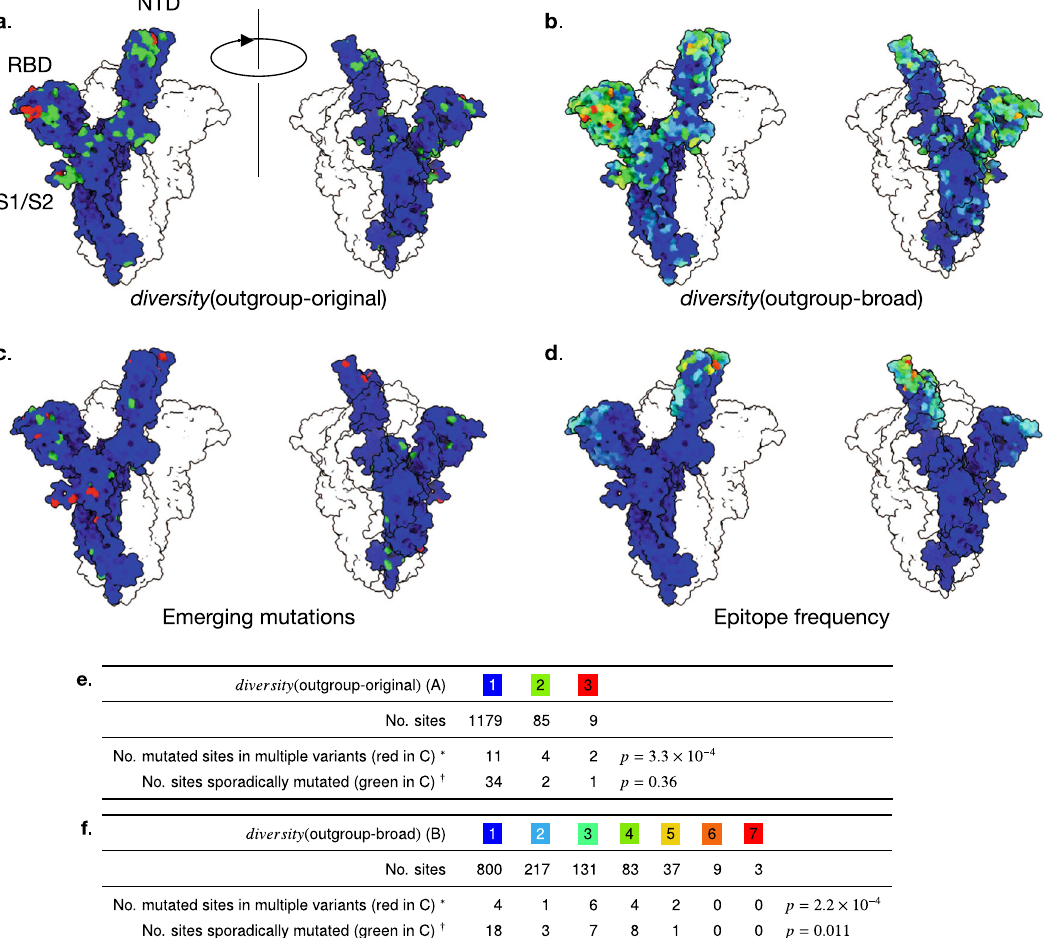
Fig. 1 Diversity and other indices mapped on structure of the S protein, visualized by ChimeraX 28 . A movie of the structure rotating is available at https:// mafft.cbrc.jp/alignment/pub/sarscov2/structure.mp4. For clarity, a single S protein is shown in the context of a spike trimer. a , b diversity (outgroup), the number of different amino acids observed at each site in outgroup, was computed using the original and broad de fi nitions of outgroup: Low diversity (blue); High diversity (red). c Emerging mutations found in single variant (green); in multiple variants (red) infecting humans. d Epitope frequency, the number of antibodies that contact each residue (<6Å), was counted based on currently available Protein DataBank (PDB) entries of S protein-antibody complexes listed in https://mafft.cbrc.jp/ alignment/pub/sarscov2/epitopefrequency.txt. 0 (blue); 15 (red). This value is not expected to represent all spike-targeting antibodies. e Correspondence between diversity (outgroup-original) ( a ) and emerging mutations ( c ). f Correspondence between diversity (outgroup-broad) ( b ) and emerging mutations ( c ). Positions of emerging mutations in c , e , and f were taken from reference 27 . Asterisk represents mutated sites in multiple variants = residues in bold in Table 2 in Peacock et al. 27 ; dagger represents sporadic mutations = the other residues listed in the